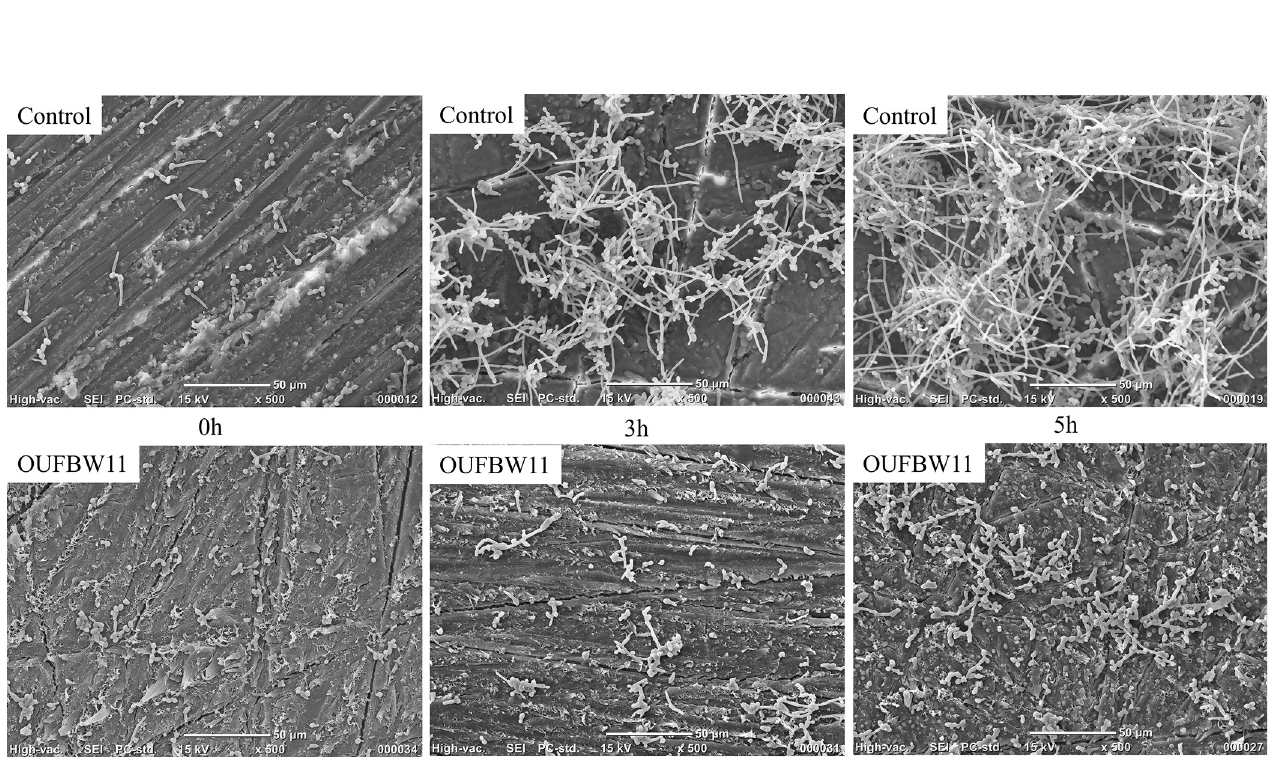
Fig 4. SEM images of C . albicans biofilms formed on the surface of each group of resin discs. The OUFBW group had fewer fungi and non-three- dimensional biofilms than the control group.